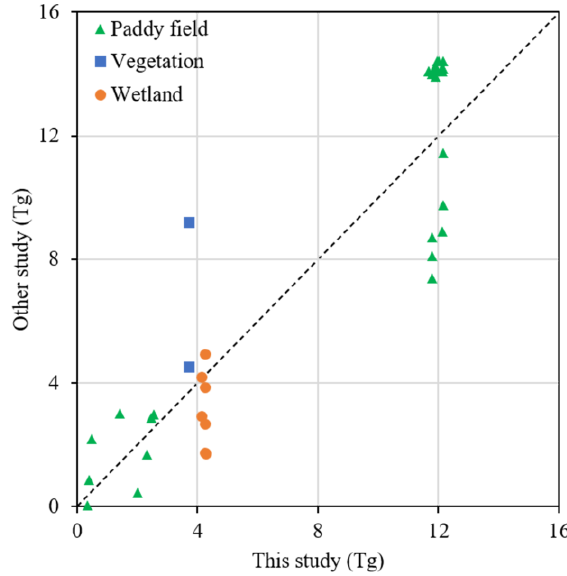
Figure 8. The comparison with other studies. Other research data in the figure come from: EDGAR v6.0 [25]; EDGAR v5.0 [26]; Gong et al. (2021) [19]; Huang et al. (2019) [18]; CSBUR [27]; Chen et al.